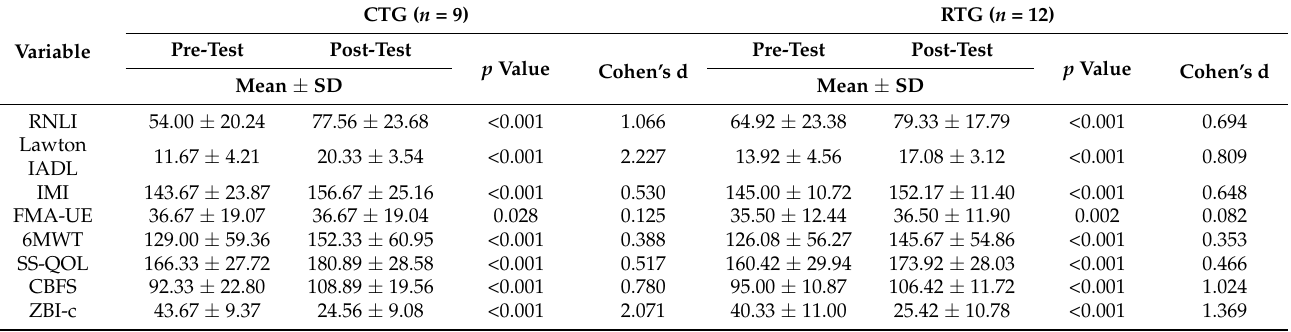
Table 2. Pre-test and post-test effectiveness outcome measures in the intervention and control groups. CTG ( n = 9) RTG ( n = Variable